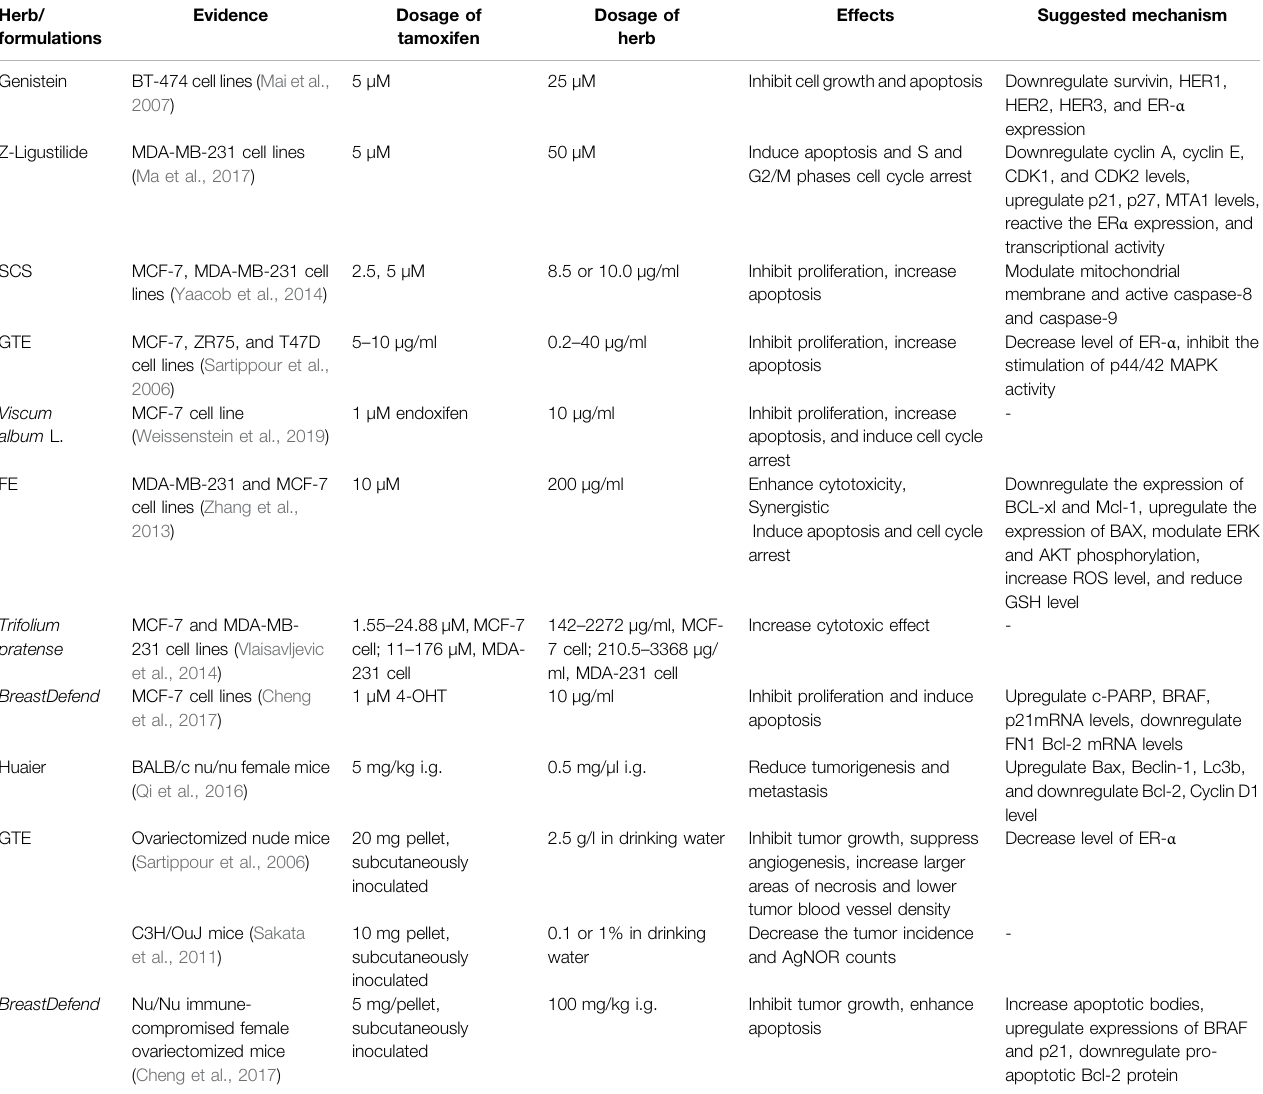
TABLE 2 | Reported synergetic effects of a combination of inhibiting tumor growth, inhibiting proliferation, or inducing apoptosis. Herb/ formulations